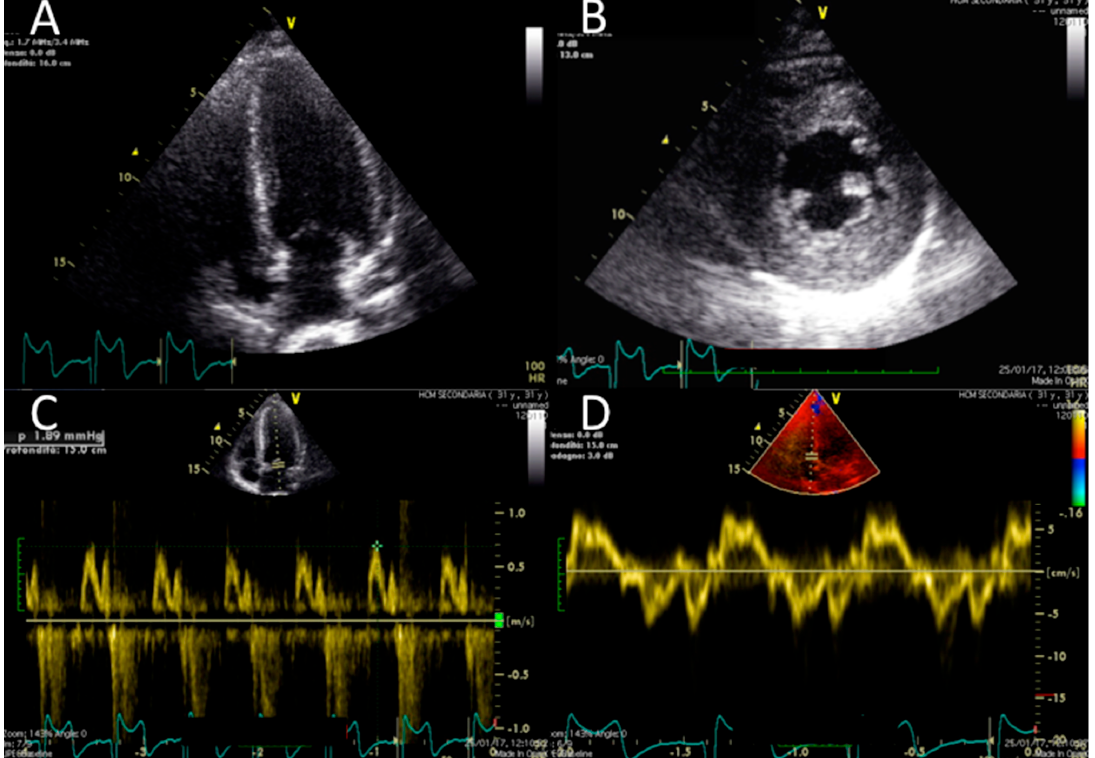
Figure 3. Echocardiographic findings. Echocardiographic findings show a moderate increase in LV thickness (max diameter 17 mm inferior and inferoseptal walls) in a four-chamber view (panel A ) and on the mid short axis (panel B ). Slightly reduced longitudinal function (S wave 0.07 cm/s) ( D ) and no significant abnormality of diastolic function (normal E/A pattern and E/E (cid:48) 10) were found (panel C and D ) (Video S1 and Video